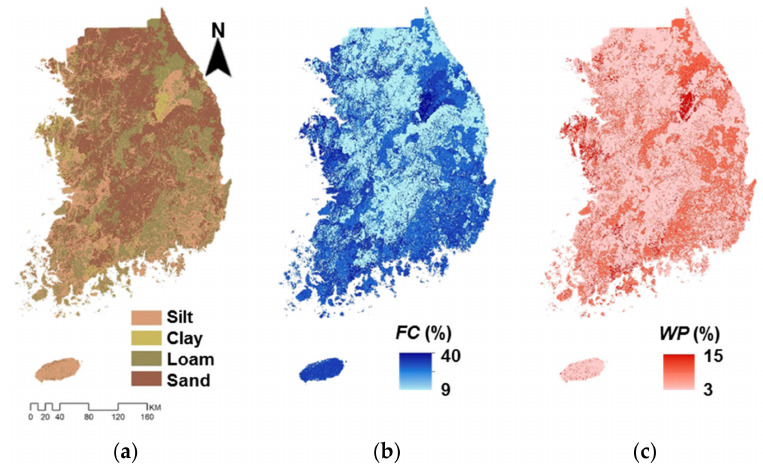
Figure 4. Distribution map of soil information with a 1 km spatial resolution: ( a ) Soil type (silt, clay, loam and sand); ( b ) soil field capacity ( FC ); and ( c ) soil wilting point ( WP